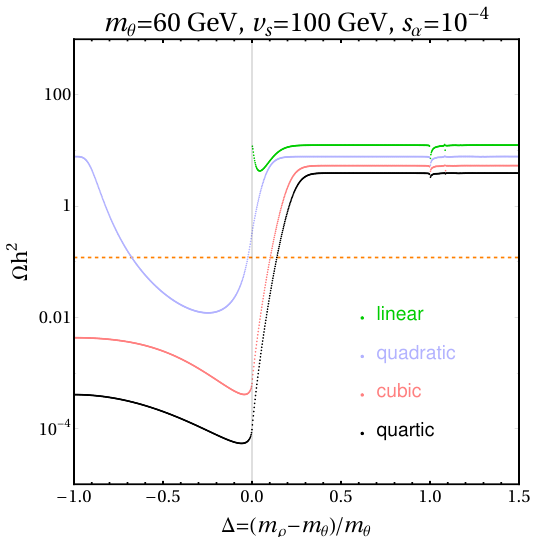
Figure 5. Relic abundance as a function of ∆ for m θ = 60 GeV , v s = 100 GeV and s α = 10 − 4 for the minimal models . The correct value for the relic abundance is shown as an orange dashed